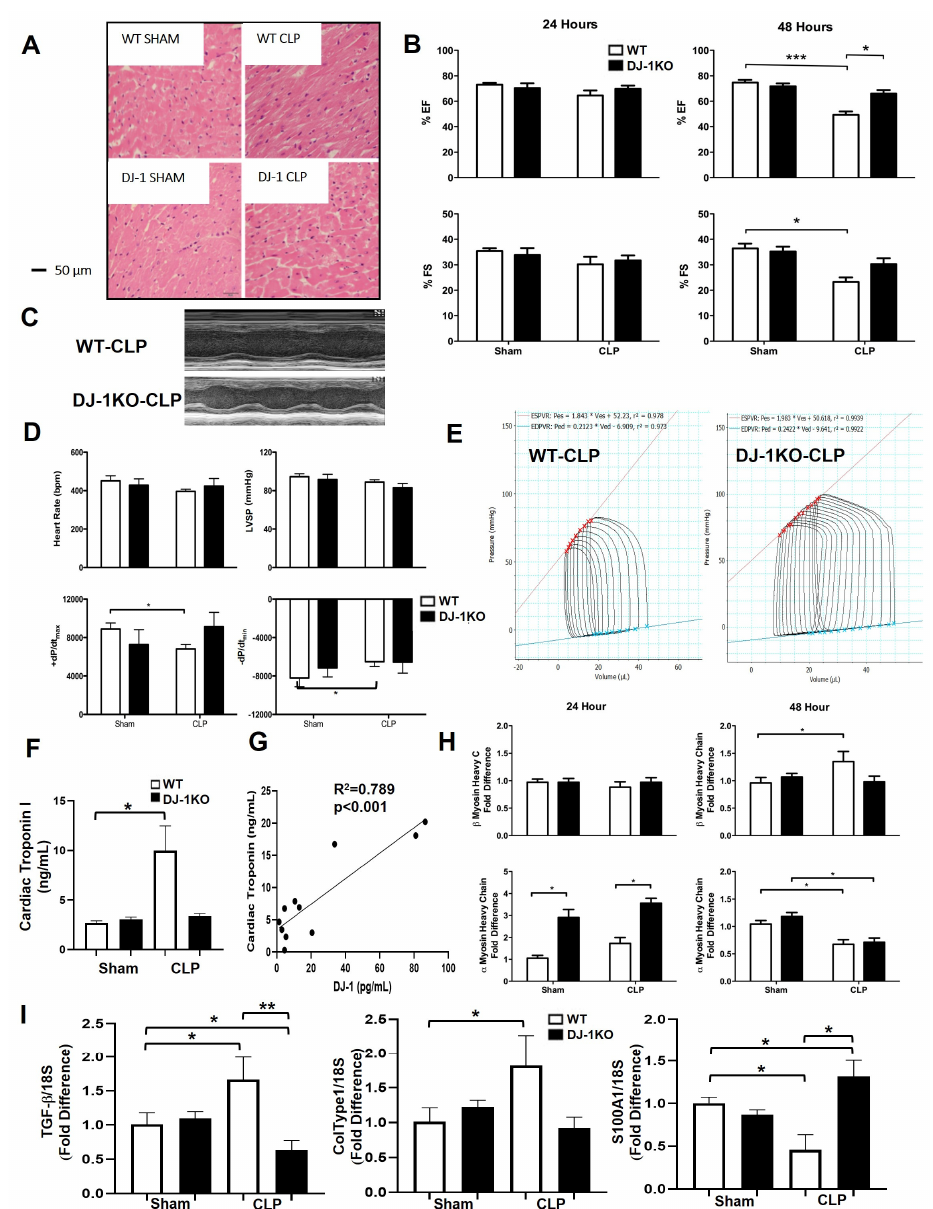
Figure 4. DJ-1KO mice are protected from sepsis-induced myocardial depression. ( A ) Representative immunohistochemical images of myocardium from WT and DJ-1KO mice at 48 h post-CLP or sham operation. ( B ) Representative m mode echocardiogram from WT and DJ-1KO mice at 48 h post- CLP. ( C ) Bars are mean + SEM of echo-derived ejection fraction (EF) or fractional shortening (FS) in WT and DJ-1KO mice at 24 and 48 h post CLP or sham operation. n = 9–11/group. ( D ) Bars are mean + SEM of heart rate (HR), LV systolic pressure, +dp/dtmax or -dp/dtmax of WT, and DJ-1-/- mice at 24 and 48 h post-CLP or sham operation. n = 9–11/group. ( E ) Representative PV loops from WT and DJ-1KO mice at 48 h post-CLP showing end systolic (ESPVR) and end diastolic (EDPVR) pressure volume relationships. ( F ) Bars are mean + SEM of plasma cardiac troponin (ng/mL) of WT and DJ-1KO mice at 24 h post-CLP or sham operation. n = 9–11/group. ( G ) A positive correlation between septic plasma DJ-1 (pg/mL) vs. cardiac troponin (ng/mL) at 24 h post-CLP. n = 11/group. ( H ) Bars are mean + SEM of β - or α -myosin heavy chain/18S mRNA expression in myocardium of WT and DJ-1KO mice at 24 and 48 h post-CLP or sham operation. n = 9–11/group. ( I ) Bars are mean + SEM of TGF- β , collagen (col) type I, or S100A1 mRNA expression in myocardium of WT and DJ-1KO mice at 48 h post-CLP or sham-operation. n = 9–11/group. * p < 0.05, ** p < 0.01, *** p <